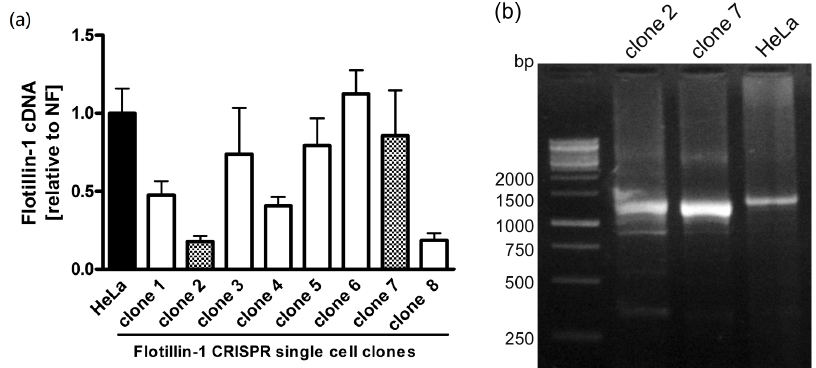
Figure 2. Quantitative real-time PCR analysis and PCR amplification of the cDNA of WT and flotillin-1 knockout HeLa clones. ( a ) qPCR analysis. Bar corresponding to wildtype HeLa cells is shown in black, shaded bars show the clones 2 and 7 that were chosen for further analysis. ( b ) cDNAs from clones 2 and 7 were subjected to PCR amplification with primers flanking the coding region of flotillin-1.